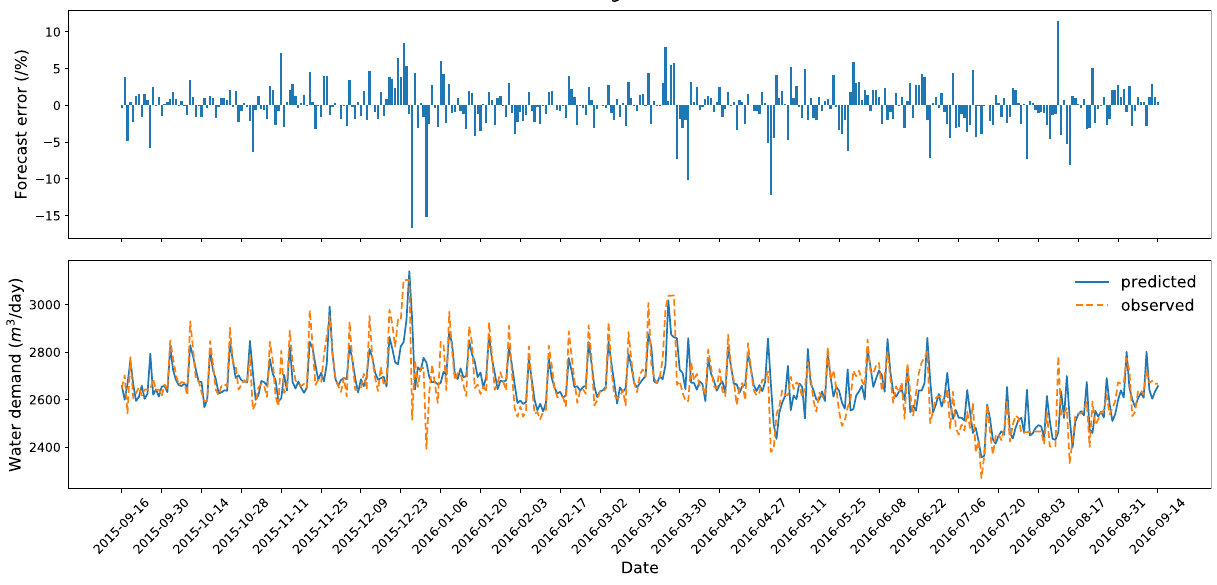
Figure 4. Research results for the best variant of forecasting—training dataset (dataset no. 3).